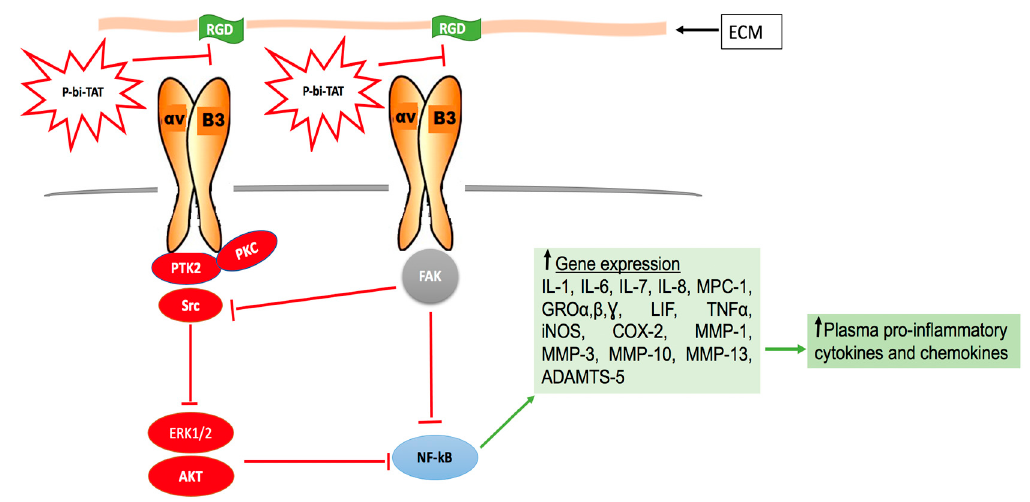
Figure 5. Scheme of the mechanism of P-bi-TAT in blocking thyrointegrin α v β 3 and its impact on NF-kB signaling path- ways. Extracellular matrix (ECM) contains the RGD cell binding sequence that can bind to the thyrointegrin α v β 3 and initiate a cell signaling cascade that results in increased expression of pro-inflammatory mediators. P-bi-TAT interferes with the interaction between RGD and thyrointegrin α v β 3, resulting in downregulation of multiple signaling pathways (FAK-Src, ERK, and AKT). P-bi-TAT downregulates NF-kB signaling pathway through activation of FAK signaling path- way. P-bi-TAT interferes with the action of NF-kB, resulting in downregulation of plasma pro-inflammatory cytokines. Red = inhibition, green = activation. Abbreviations: ADAMT = a disintegrin and metalloproteinase with a thrombospondin, RGD = arginyl glycyl aspartic acid, ERK = extracellular-signal-regulated kinase, FAK = focal adhesion kinase, IL = interleukin, MMP = Matrix metalloproteinase, PKC = protein kinase C, PTK2 = protein tyrosine kinase 2, and NF- κ B = nuclear factor kappa-light-chain B.